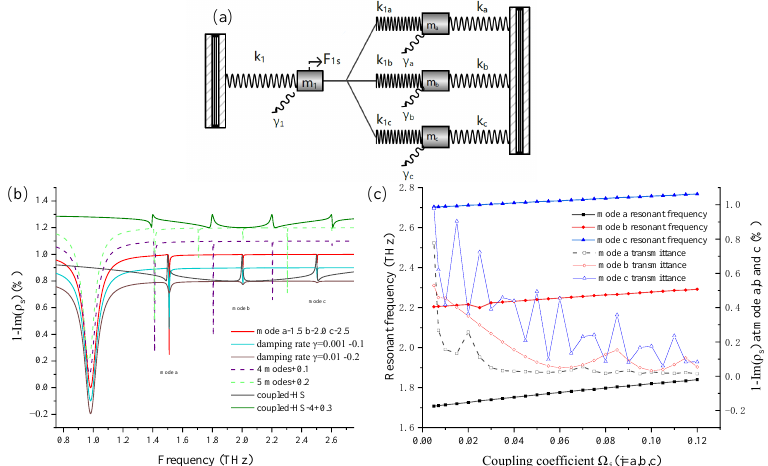
Figure 1. ( a ) A schematic of the modified HSO model with four oscillators. The model is composed of four oscillators, namely m 1 , m a , m b , and m c . They are connected to each other and to walls using seven springs with different spring constants, k j ( j = 1, a , b , c ,1 a ,1 b ,1 c ) . A driven force F 1 s ( t ) = Fe − i ω s t acts on m 1 , and m 1 oscillates with a damping rate of γ 1 under the combined action of F 1 s and other connected springs. Correspondingly, the other three oscillators also oscillate passively owing to their connected springs with a damping rate of γ j ( j = a , b , c ) . ( b ) Illustration of the spectra of 1 − Im ( ρ s ) with varying parameters. The initial frequency ω j ( j = 1, a , b , c ) identifies the position of the transmission dip in the spectra, and the damping rate influences the resonant response. The EIT effect is related to whether the initial frequency and the response bandwidth of each mode are overlapped. The influence of the damping rate on the resonant response is also compared, and the amplitude of the spectrum is subtracted from 0.1 and 0.2 for a clear distinction. A comparison of the spectra based on the HSO system with four or five passive modes in the uncoupled state is shown. Their amplitudes are added with 0.1 and 0.2 to distinguish them from other spectra. A tetradic band EIT effect in the spectra when the active mode couples with four other passive modes in the HSO model. ( c ) The changing trend of 1 − Im ( ρ s ) decreases and the resonant frequency gradually increases when the coupling coefficient Ω j ( j = a , b , c ) increases from 0.005 to